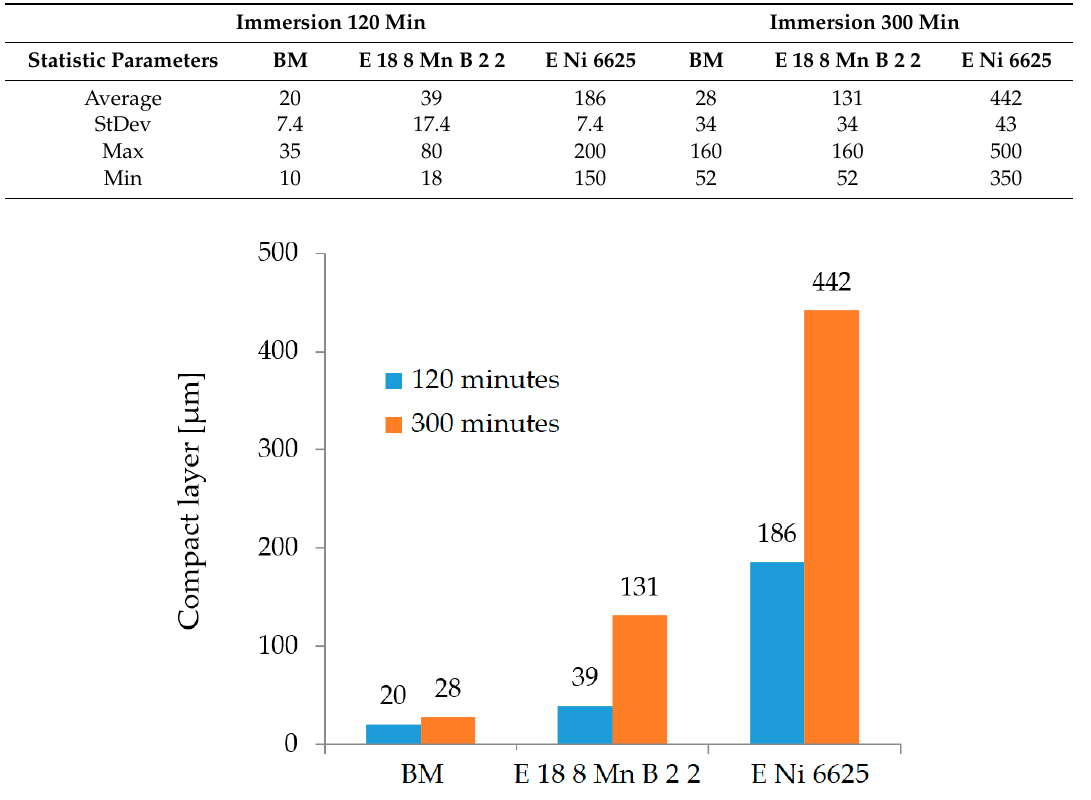
Figure 26. Compact layer thickness.